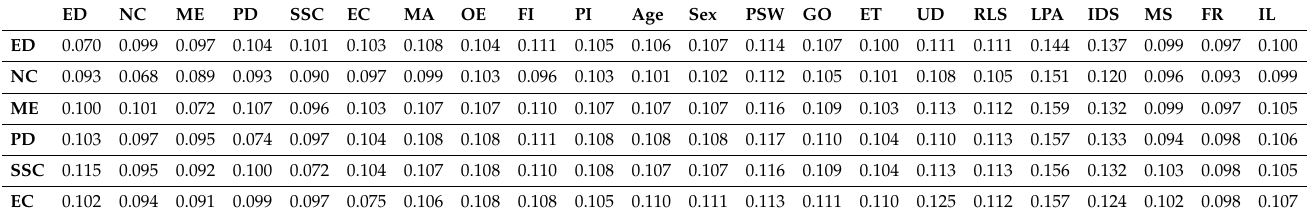
Table 4. Total relation matrix